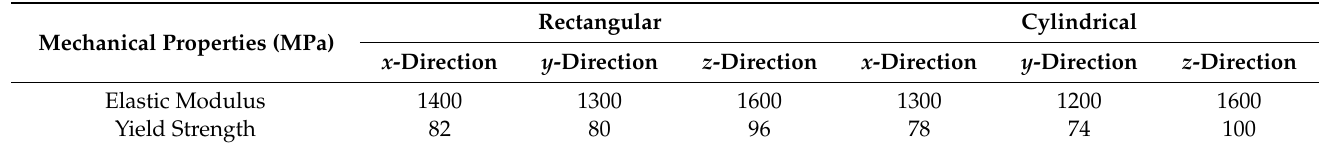
Table 7. Mechanical properties of the 3D-printed standard